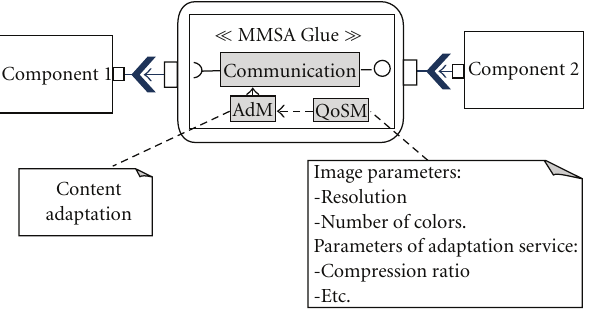
Figure 12: Adaptation connector of image content.